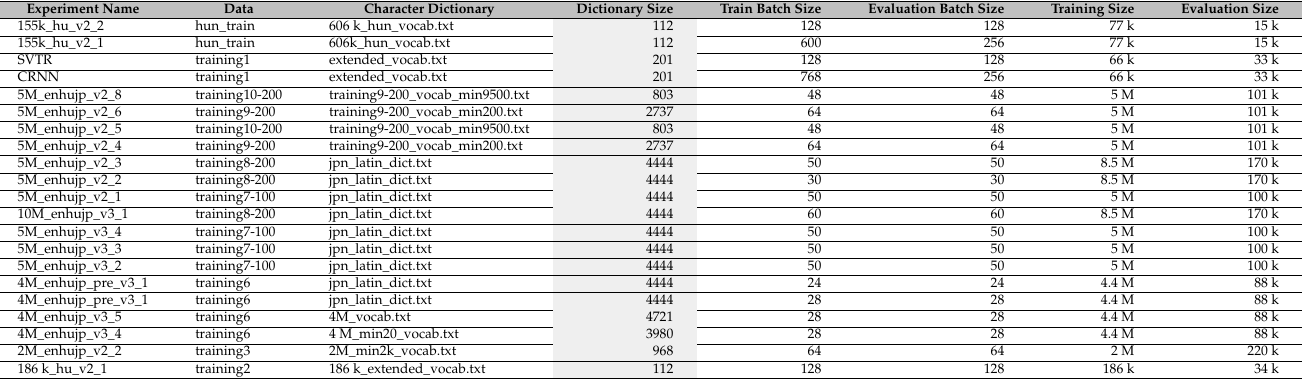
Table 3. Training names, training data, and batch sizes.